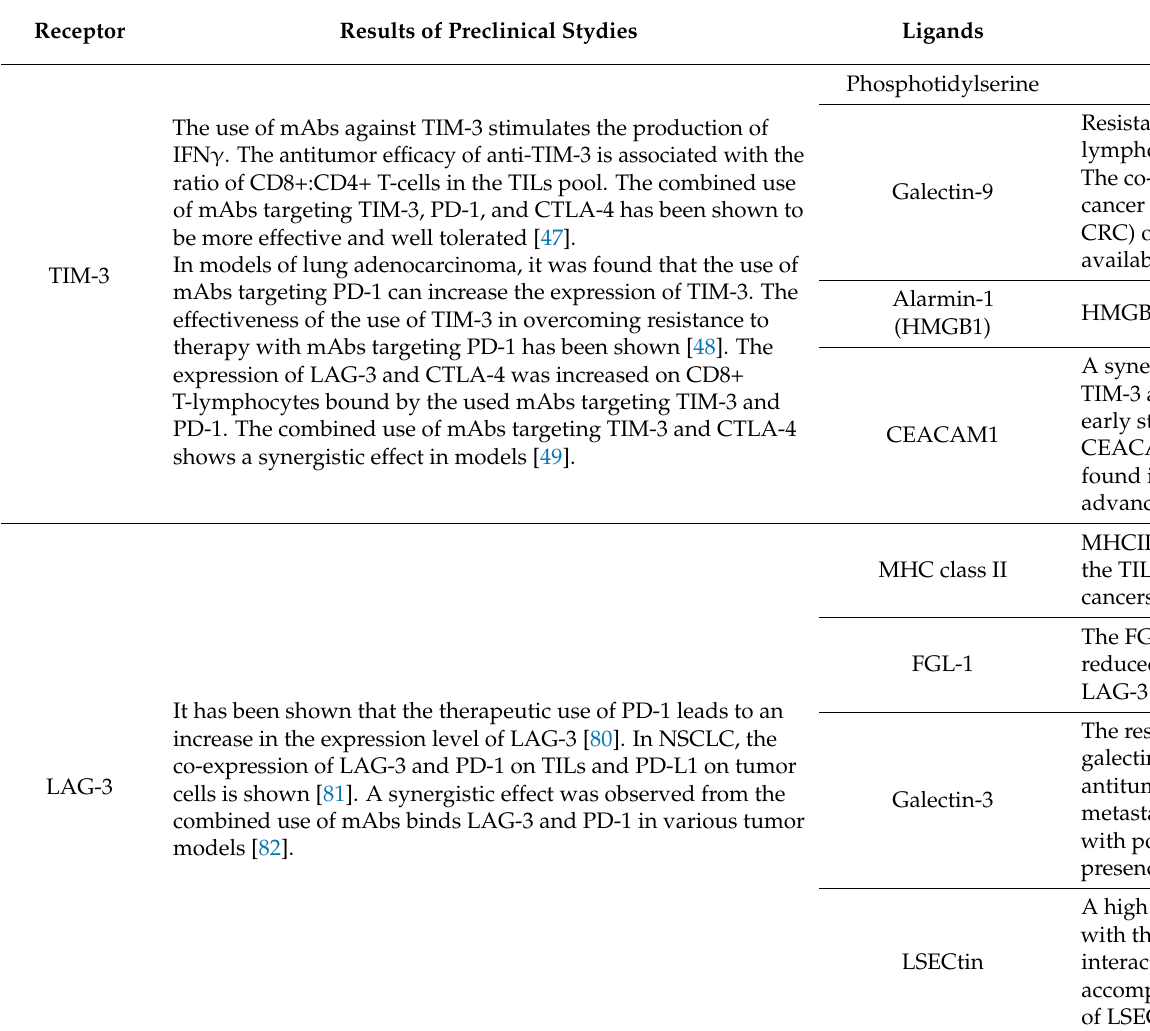
Table 1. Clinical significance and results of preclinical studies of ICs and their